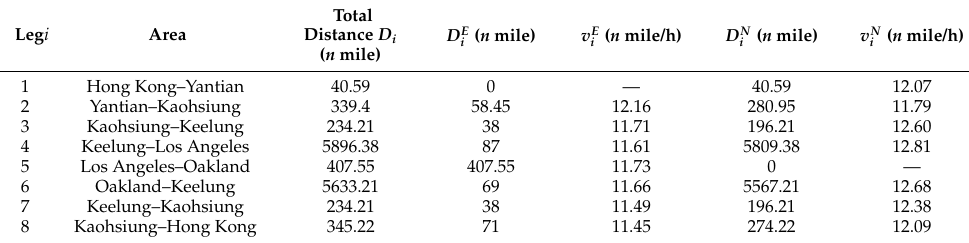
Table 7. Results of multi-objective optimization of speed.